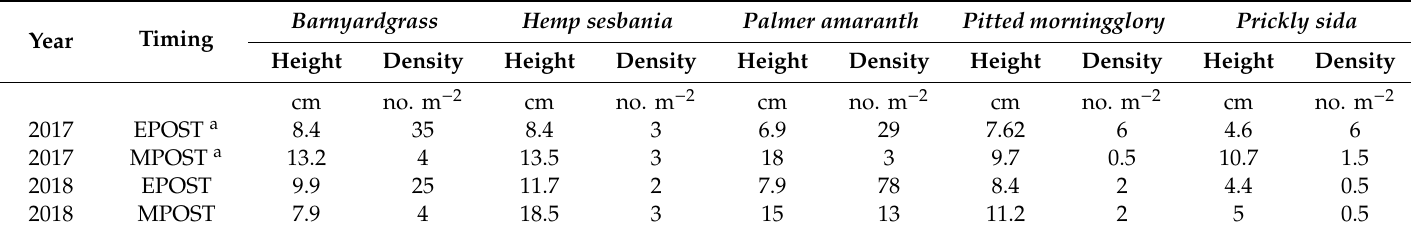
Table 2. Height and density of barnyardgrass, hemp sesbania, Palmer amaranth, pitted morningglory, and prickly sida in the Weed Control Study at Stoneville,